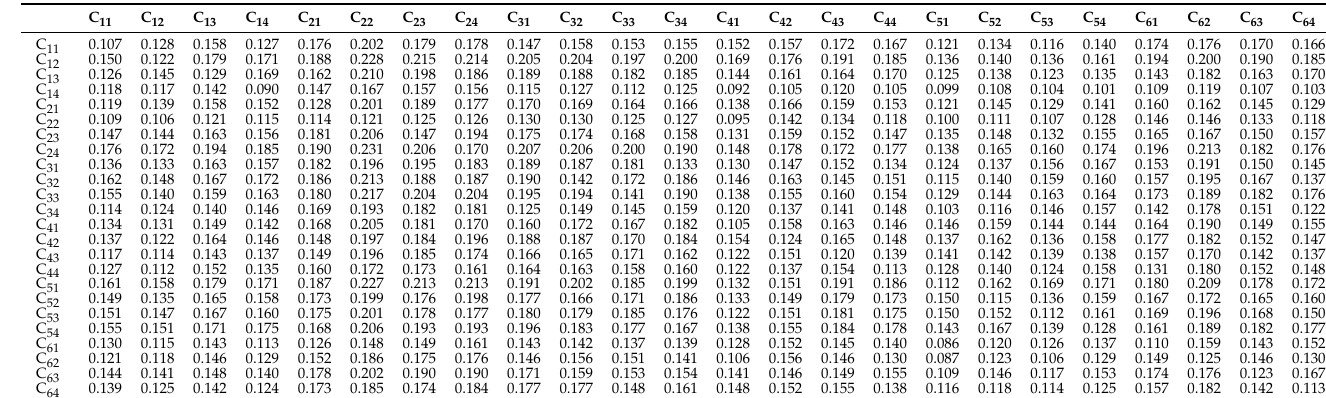
Table 4. Comprehensive influence matrix of the second-level influencing